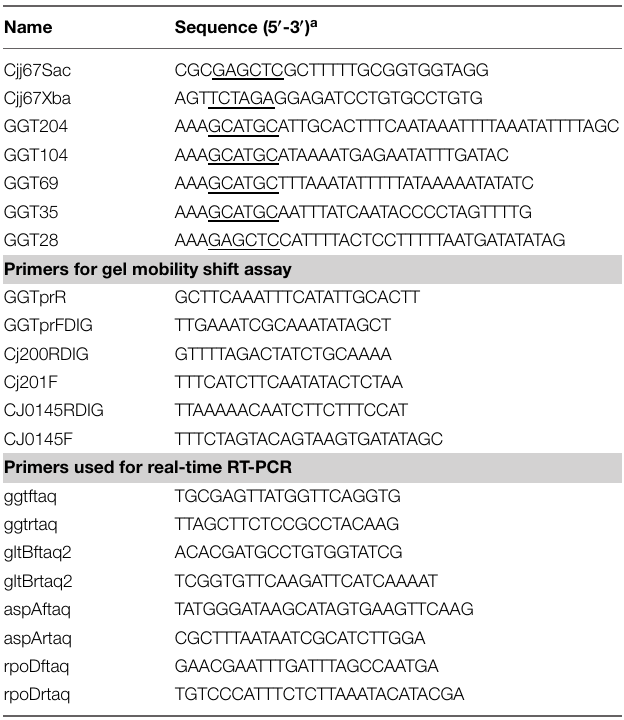
TABLE 2 | Oligonucleotides used in this